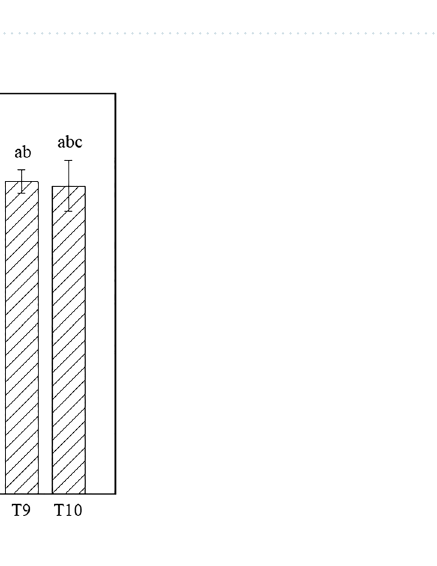
Figure 4. Bulk density under the different treatments (the different letters denote significant differences at the 0.05 level).